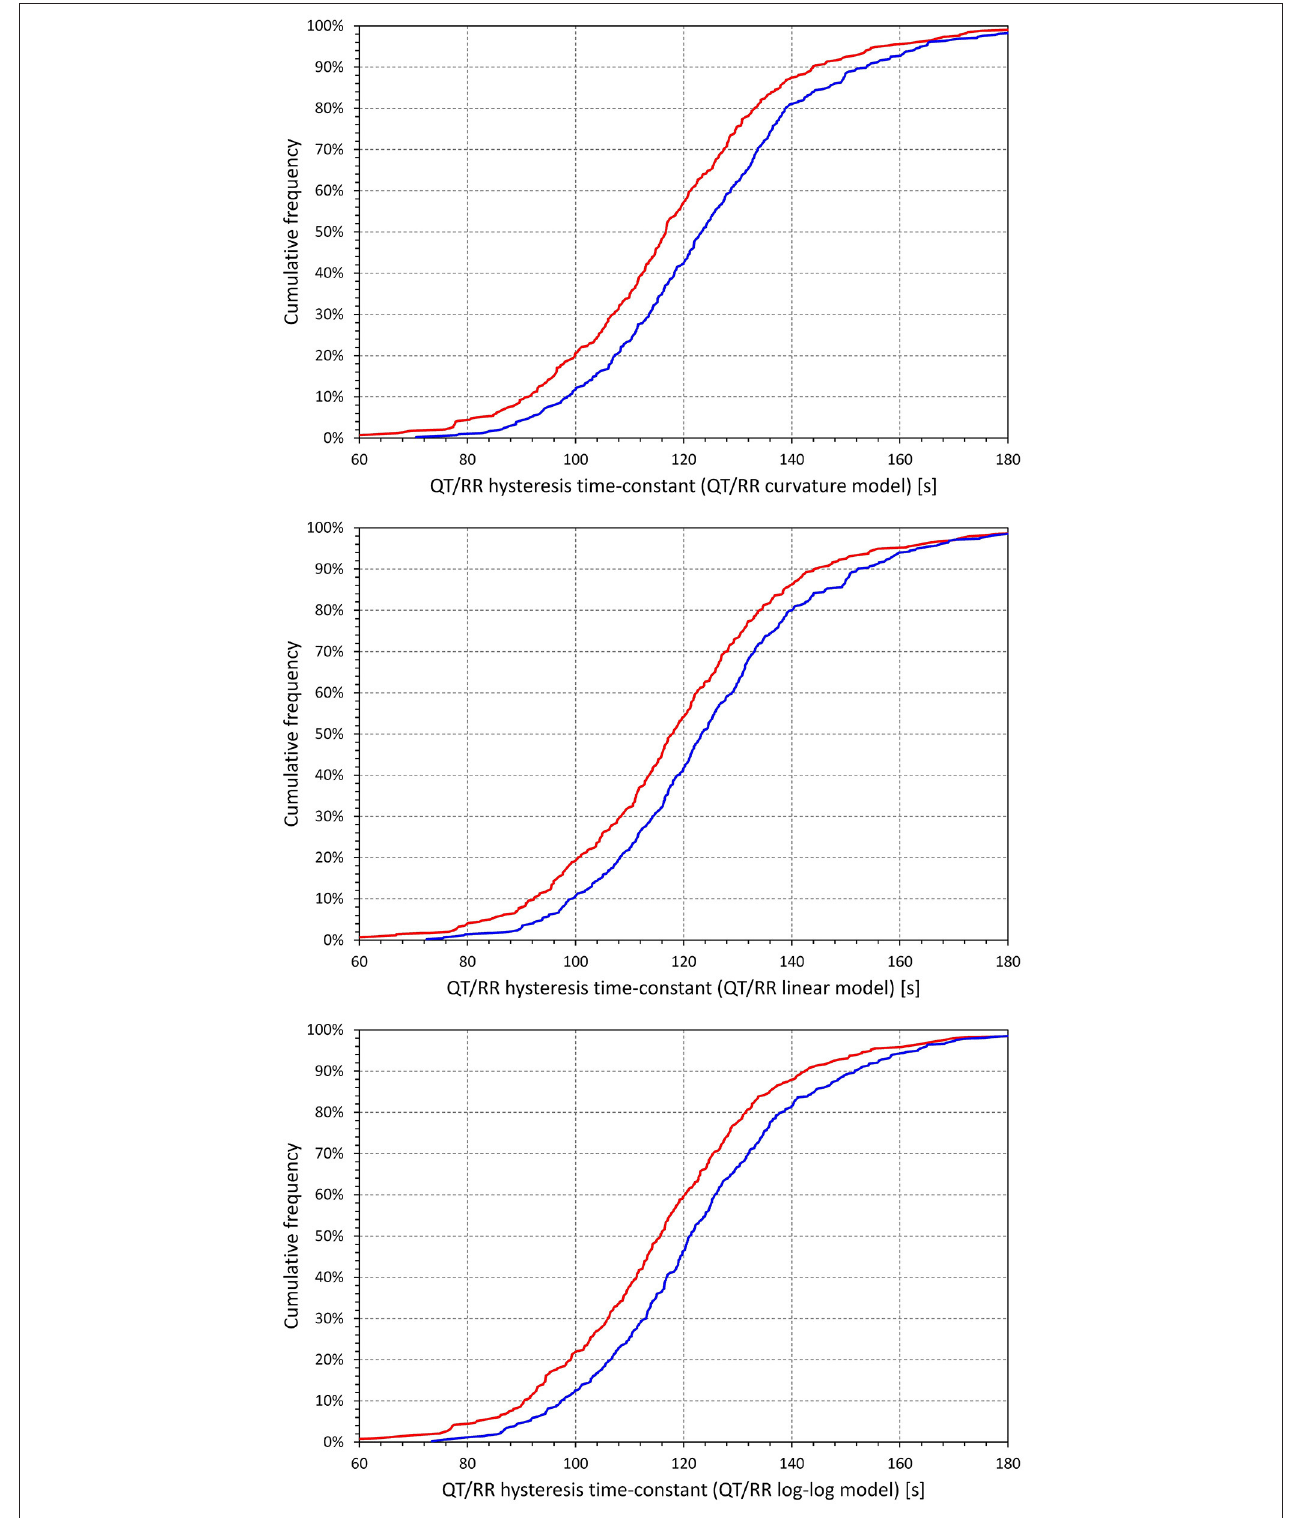
FIGURE 7 | Cumulative distributions of QT/RR hysteresis time-constants derived from the combination with the QT/RR H curvature model (top panel), linear model (middle panel), and log-log model (bottom panel). In each of the panels, the red and blue lines correspond to females and males, respectively.